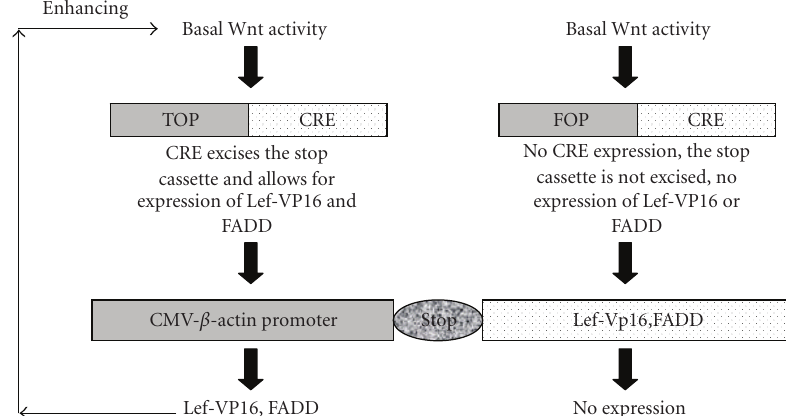
Figure 4: Positive upregulation using the modular Cre/lox system. Floxed e ff ectors can include positive upregulators of the transcriptional activity driving Cre expression. For example, in this model system, Lef-VP16, which upregulates Wnt activity, is expressed from a floxed vector in a Wnt activity-specific manner. The Lef-VP16 feeds back to stimulate Wnt activity, resulting in higher levels of Cre expression and, hence, more production of the floxed e ff ectors, which includes not only the Lef-VP16 itself but also gene products resulting in, for example, cell death. Positive feedback increases the overall e ffi ciency of the system, amplifying the original transcriptional signal, and can be used to enhance the e ff ectiveness of the system under suboptimal conditions, adapted from [33].